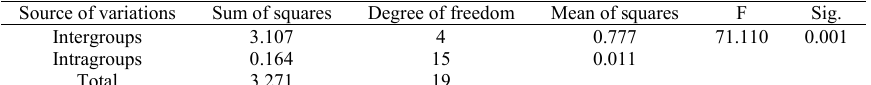
Table14: Analysis of variance of OD at different antibacterial concentrations of nisin.